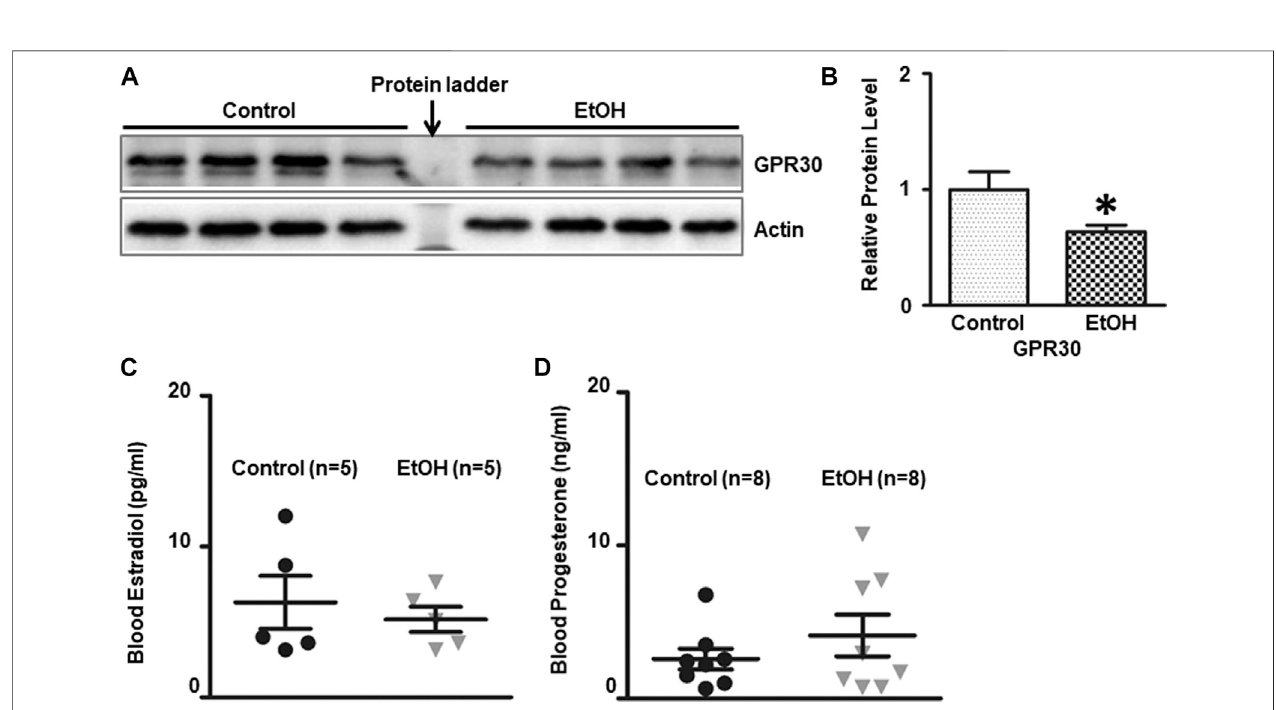
FIGURE 8 | Effects of chronic alcohol exposure on the expression of G-protein-coupled estrogen receptor (GPR30) in the brain, and estradiol/progesterone levels in the blood. (A) The expression of GPR30 in the cerebrum was determined by IB. (B) The relative amounts of expression were quanti fi ed and normalized to the expression of actin. The results were expressed as the mean ± SEM, n (cid:2) 4 for each group. * p < 0.05 denotes a statistically signi fi cant difference from the control group. The concentration of estradiol (C) and progesterone (D) in the blood was determined by ELISA as described in the Materials and Methods . n (cid:2) 5 for estradiol test, and n (cid:2) 8 for progesterone